Question: What type of chart is this?
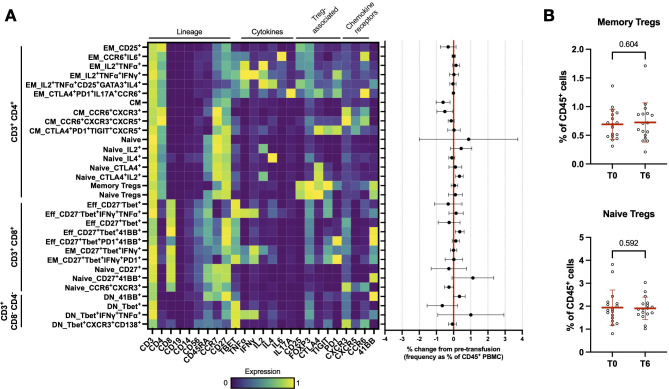
Answer: heatmap